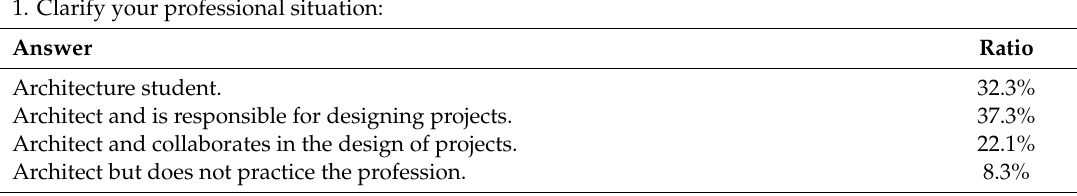
Table A1. Statistics of